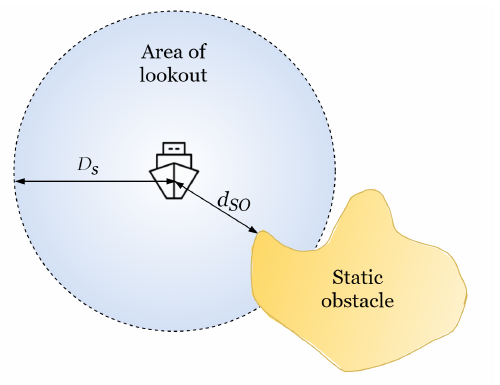
Figure 2. Representation of the area of lookout around the surface vessel and a static obstacle in the close